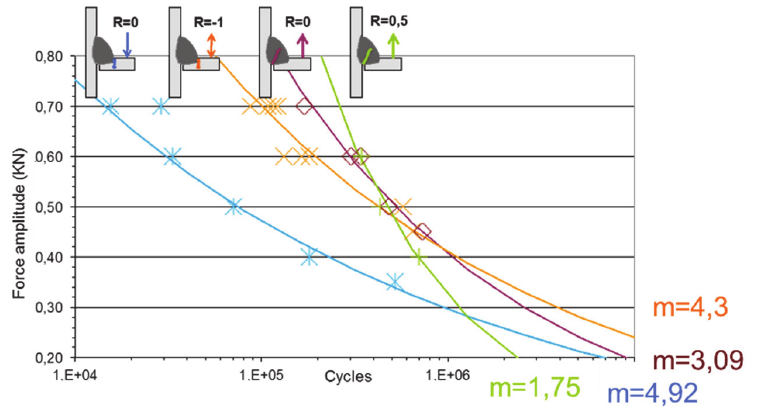
Figure 4: Fatigue life under bending for different load